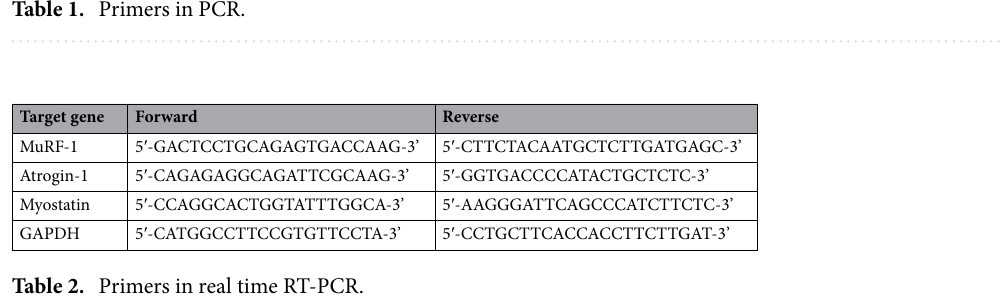
Table 1. Primers in PCR.